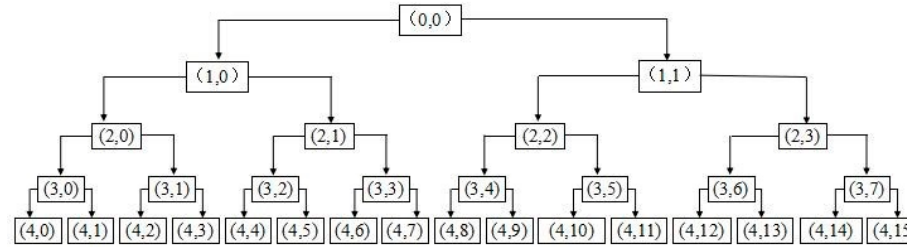
Figure 10. Decomposition tree of wavelet packet in four layers.